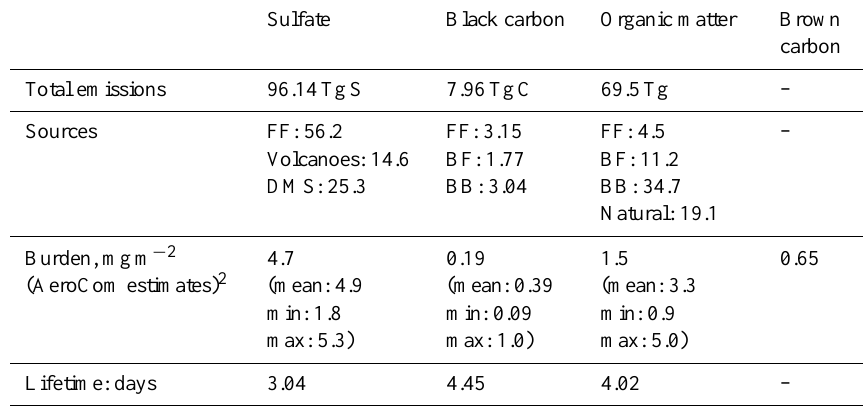
Table 1. Annual emissions and burdens of anthropogenic aerosols and their lifetimes, simulated for year 2000 1 .